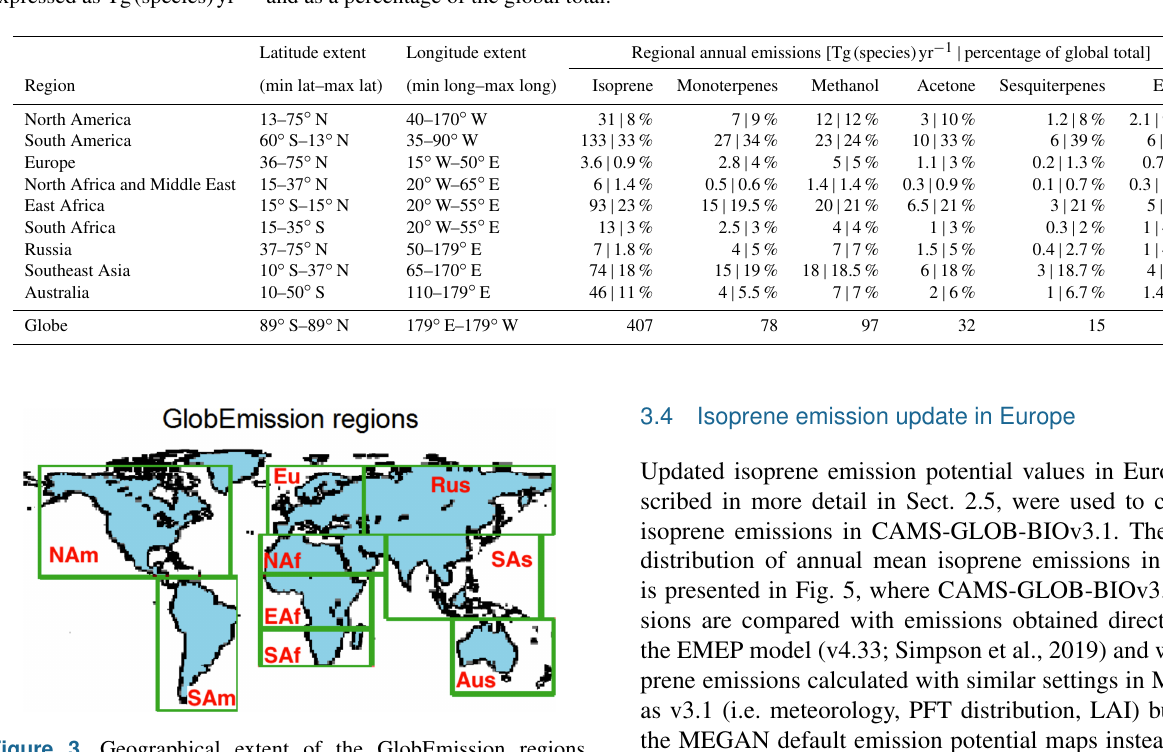
Figure 2. Global monthly totals (a) , zonal means (b) and global annual totals (c) of the isoprene emissions for the period of 2000–2019 in the CAMS-GLOB-BIOv3.1 inventory. Table 6. Regional annual emissions for CAMS-GLOB-BIOv3.1 isoprene, monoterpenes, methanol, acetone, sesquiterpenes and ethene expressed as Tg(species)yr − 1 and as a percentage of the global total.